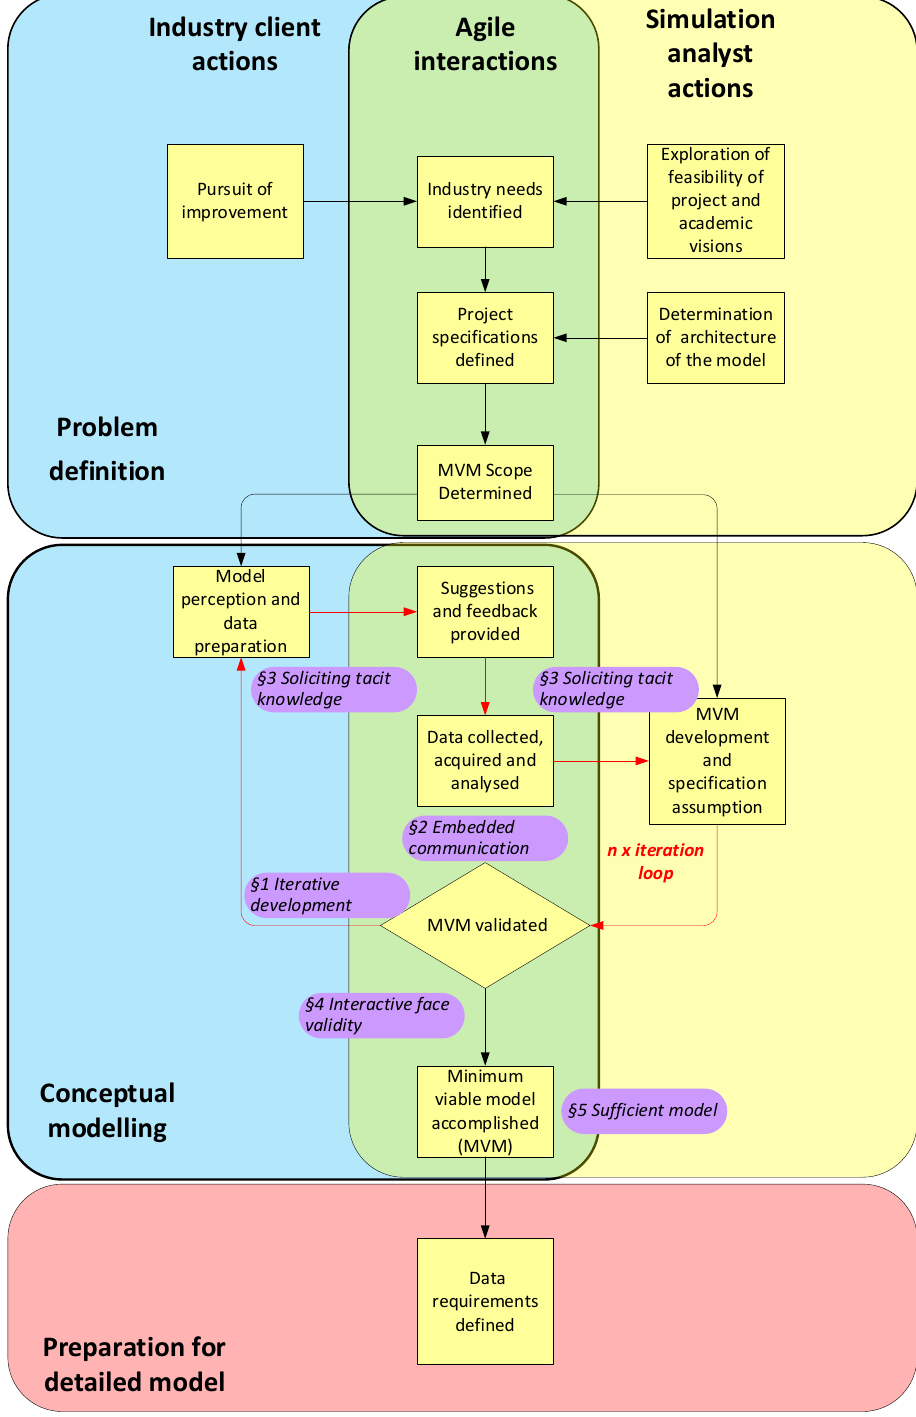
Figure 5. MVM development process with five principles.